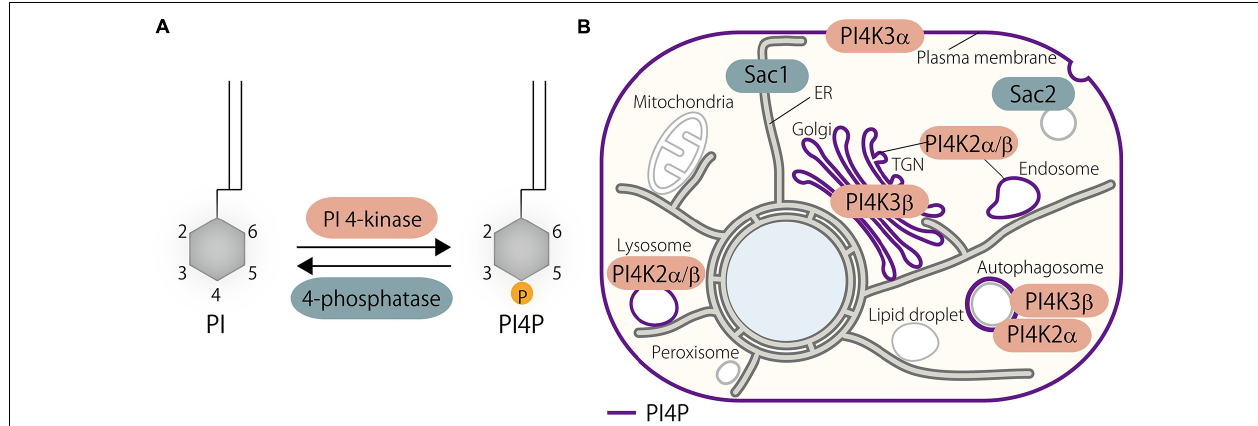
FIGURE 1 | Phosphatidylinositol 4-phosphate (PI4P) metabolism in the cell. (A) De novo PI4P synthesis is catalyzed by PI 4-kinases that phosphorylate phosphatidylinositol (PI) at the D4 position of the inositol ring. Dephosphorylation of PI4P is mediated by 4-phosphatases. (B) Distribution of PI4P and its kinases and phosphatases in the mammalian cell. PI4P is synthesized at the plasma membrane (PM), Golgi, and endosomes/lysosomes by PI4K3 α , PI4K3 β , and PI4K2 α / β , respectively. PI4K2 α and possibly PI4K3 β as well contribute to the generation of a pool of PI4P at autophagosomes. Metabolic degradation of PI4P is mediated by PI4P phosphatases such as Sac1 and Sac2/INPP5F. PI, phosphatidylinositol; PI4P, phosphatidylinositol 4-phosphate; TGN, trans -Golgi network.